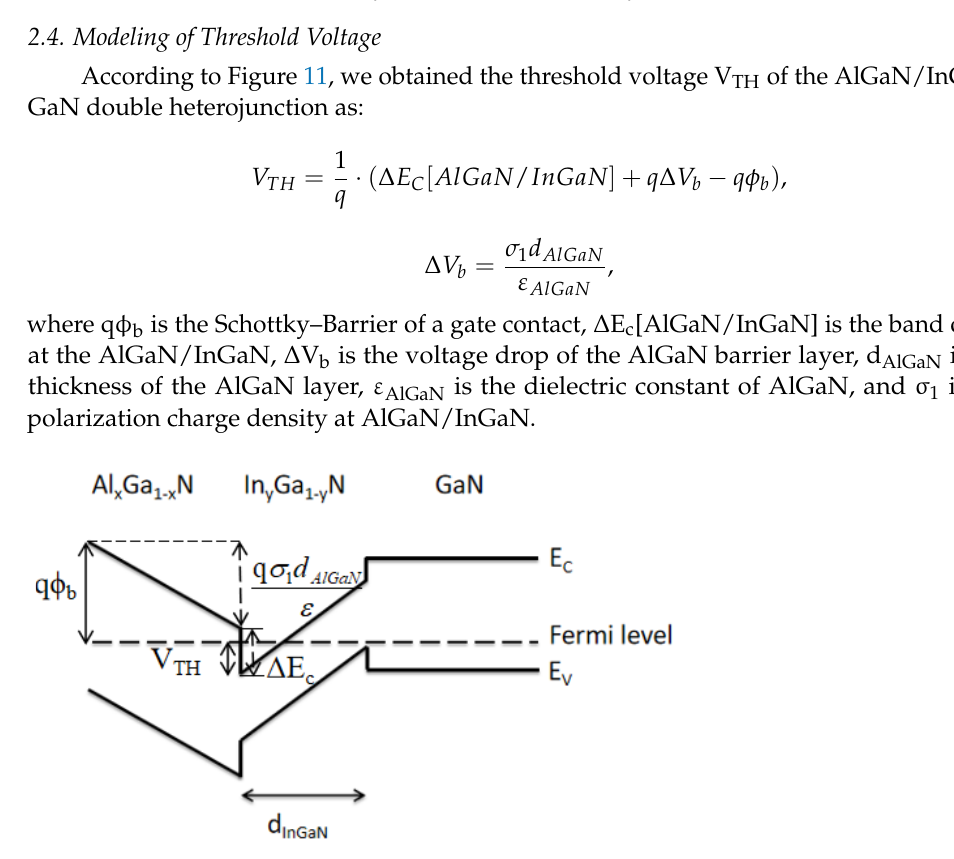
Figure 10. When Al % = 0.2, the In mole fraction is 0.1 and the InGaN layer r = 0.5; the 2DEG density at the AlGaN/InGaN, the 2DHG density at the InGaN/GaN, and the total 2DEG in the AlGaN/InGaN/GaNHEMT density with different AlGaN layer thickness.